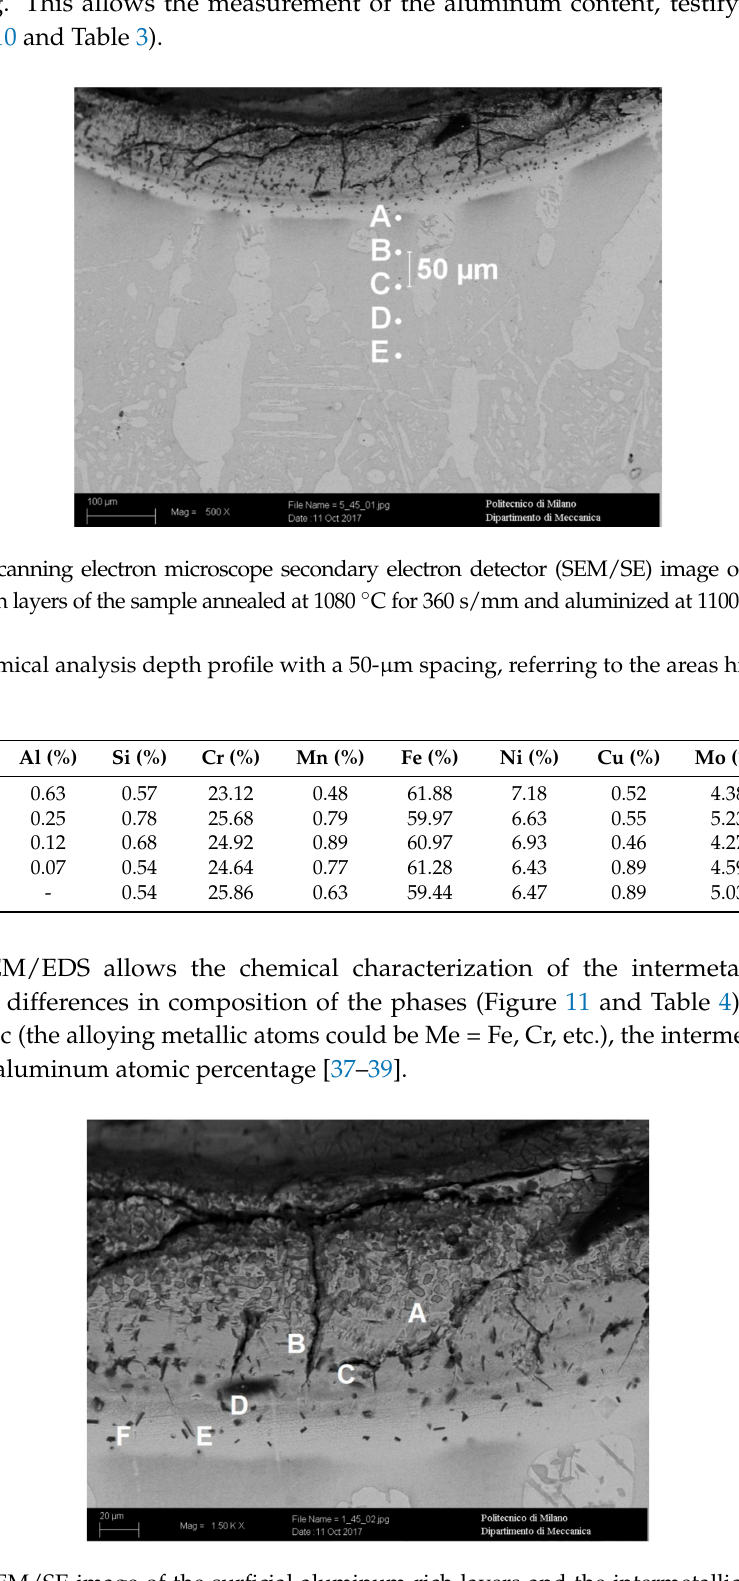
Figure 11. SEM/SE image of the surficial aluminum-rich layers and the intermetallic compounds precipitates with of the sample annealed at 1080 ◦ C for 72 s/mm and aluminized at 1100 ◦ C for 2700